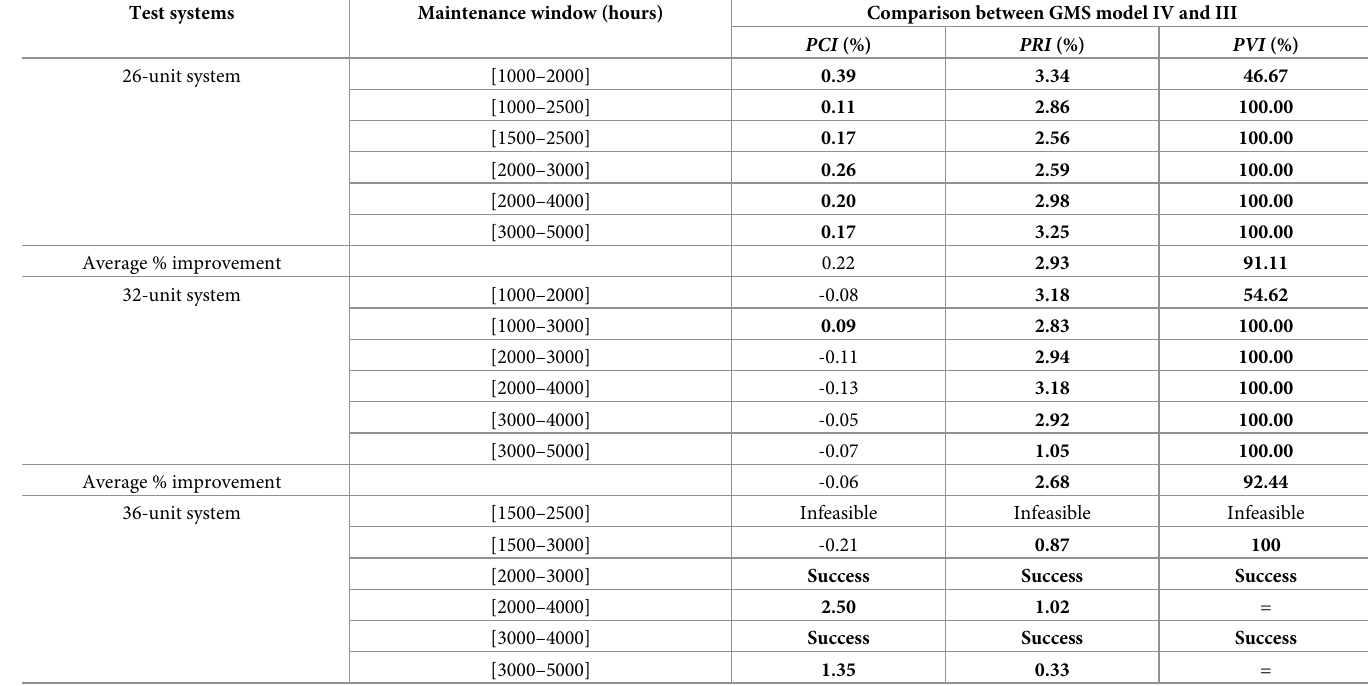
Table 13. Percentage of cost, gross reserve, and violation improvements between GMS model IV and GMS model III. Test